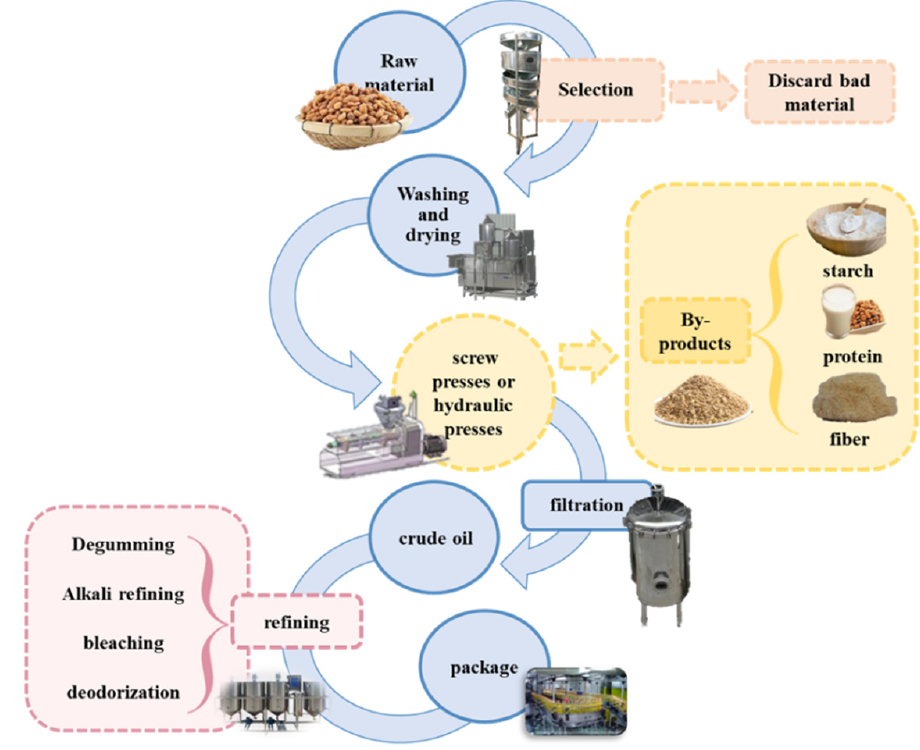
Figure 2. The preparation of tiger nut oil in food industry and by-products generated. Tiger nut oil can replace animal fat in meat products [44]. It was applied as a substitute for animal fat in the production of deer and beef burgers. By the addition of 3 g/100 g of tiger nut oil, deer burgers had a similar textural and sensory properties with the burgers containing pork fat as a lipid source [45]. The total replacement of beef fat by tiger nut oil emulsion in beef burgers resulted in a healthier meat product with rich unsaturated fatty acids but low total fat and saturated fatty acid contents, which improved the nutritional quality of burgers [46]. The researchers observed a significant decrease in the fat content in burgers with animal fat replacement. The reformulated batches could be labelled as “low fat” burgers, which is a great advantage for high consumer